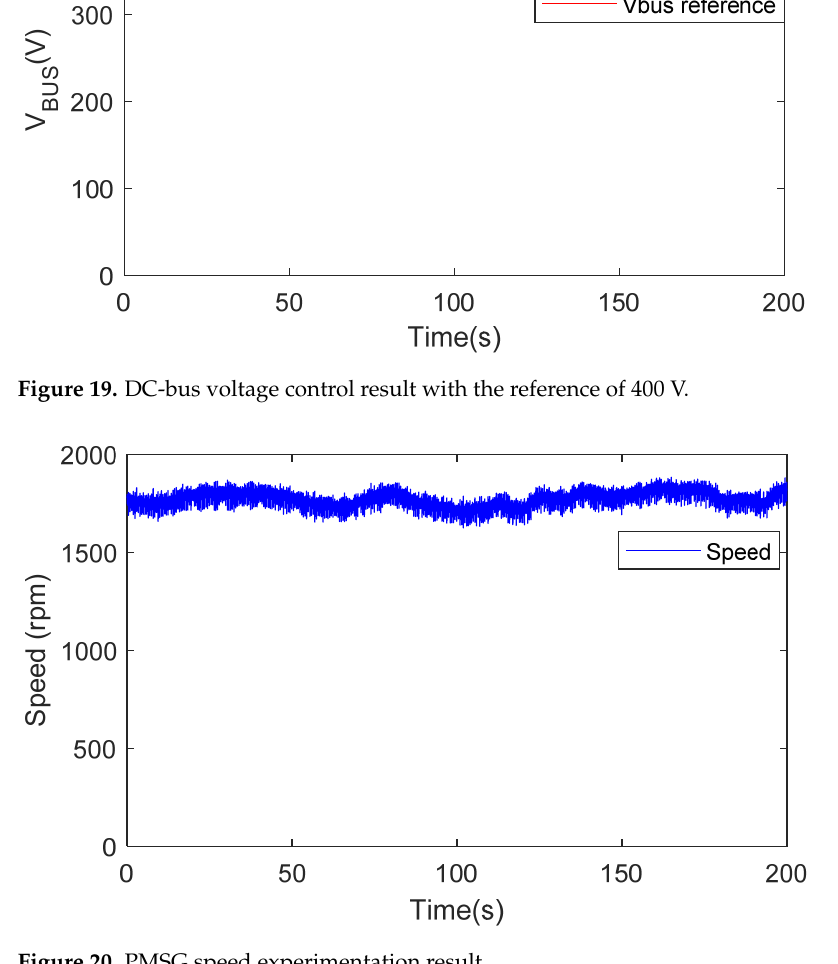
Figure 20. PMSG speed experimentation result.